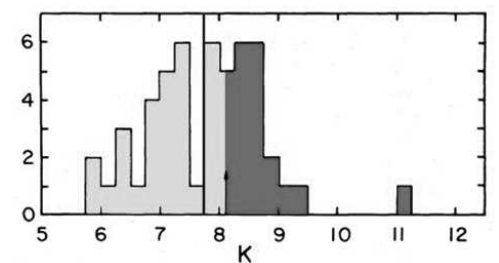
Figure 1: Distribution of galactic GCs at different K (Katz, 1980). The quantity K is related to W 0 (see Merafina & Vitantoni, Part